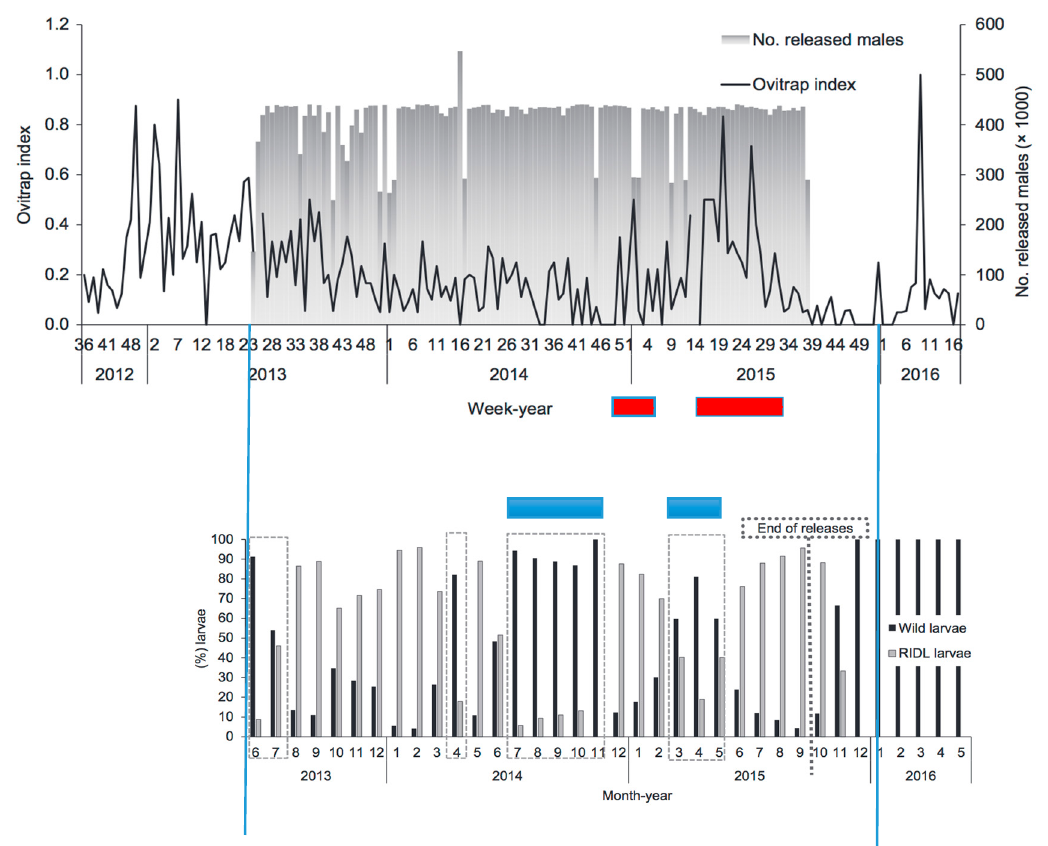
Figure 7. Results of releasing Aedes aegypti males carrying a dominant lethal gene in Jacobina, Bahia, Brazil. Blue lines were added to line up the same time in the two graphs taken from [63]. ( Upper graph ) shows the numbers released each week (grey bars, right scale). Dark line in upper graph is the ovitrap index as a measure of fertile female adults present. ( Lower graph ) shows the frequencies of wild type larvae reared from eggs in ovitraps (dark black lines) and F 1 offspring from mating with the RIDL release strain (grey lines).